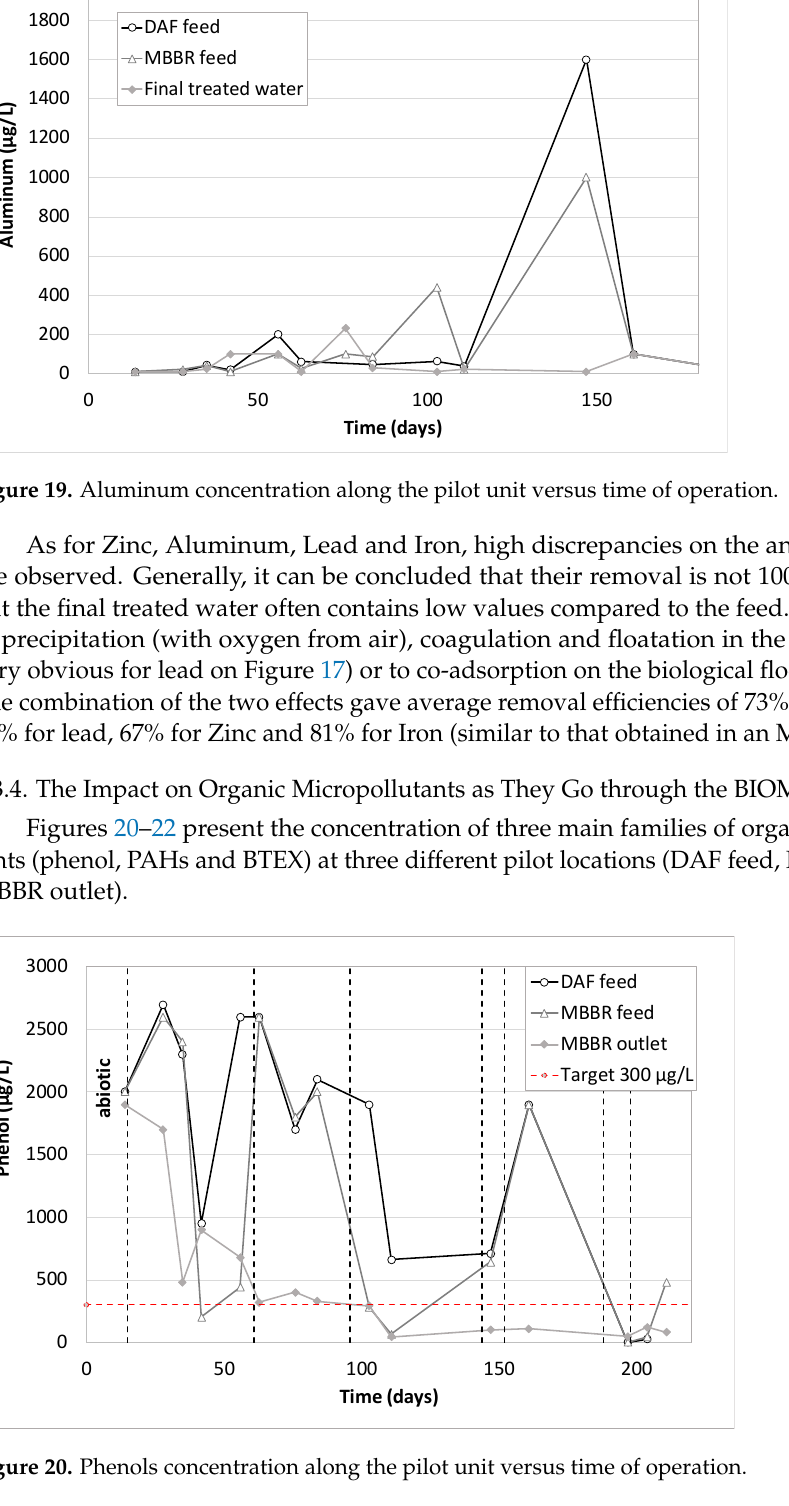
Figure 20. Phenols concentration along the pilot unit versus time of operation.